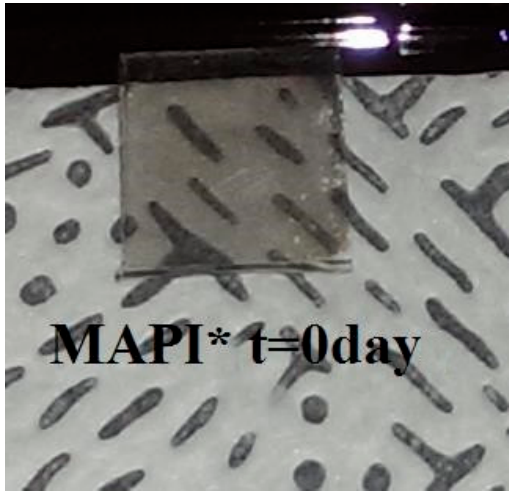
Figure 5. Photograph of the MAPI* thin layer at t = 0 day.